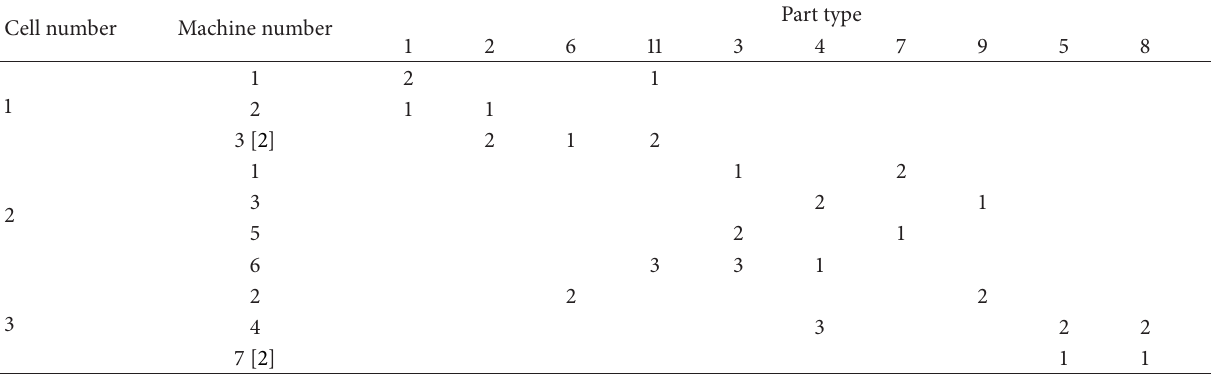
Table 6: A solution matrix for Example 1.